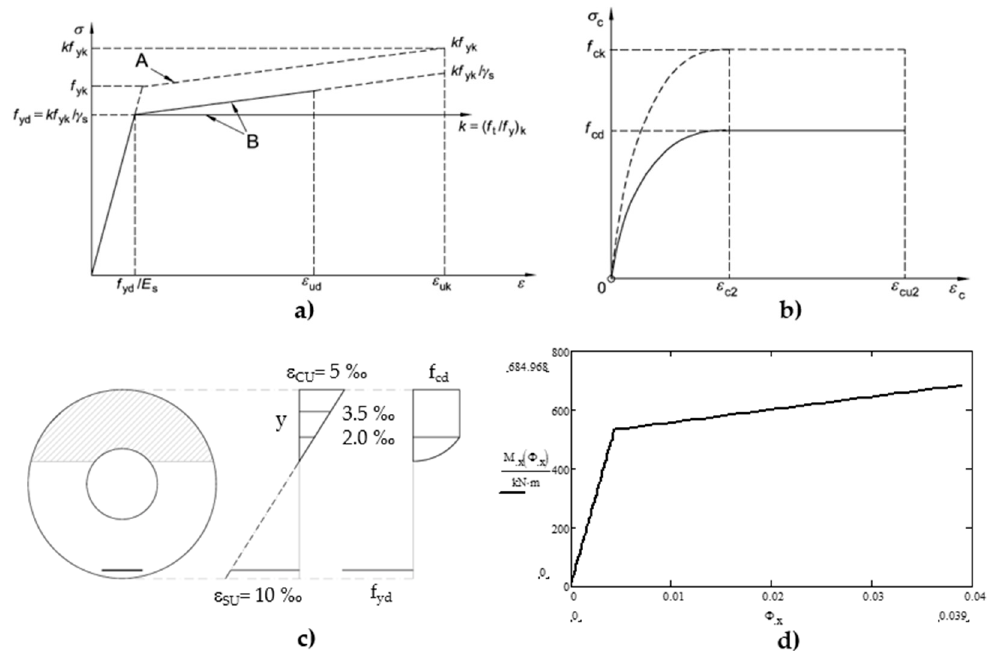
Figure 5. Some details of the safety evaluation: constitutive law of ( a ) reinforcing steel, and ( b ) confined concrete; ( c ) circular crown reinforced concrete cross-section strain and stress distribution; ( d ) resulting moment-curvature diagram.